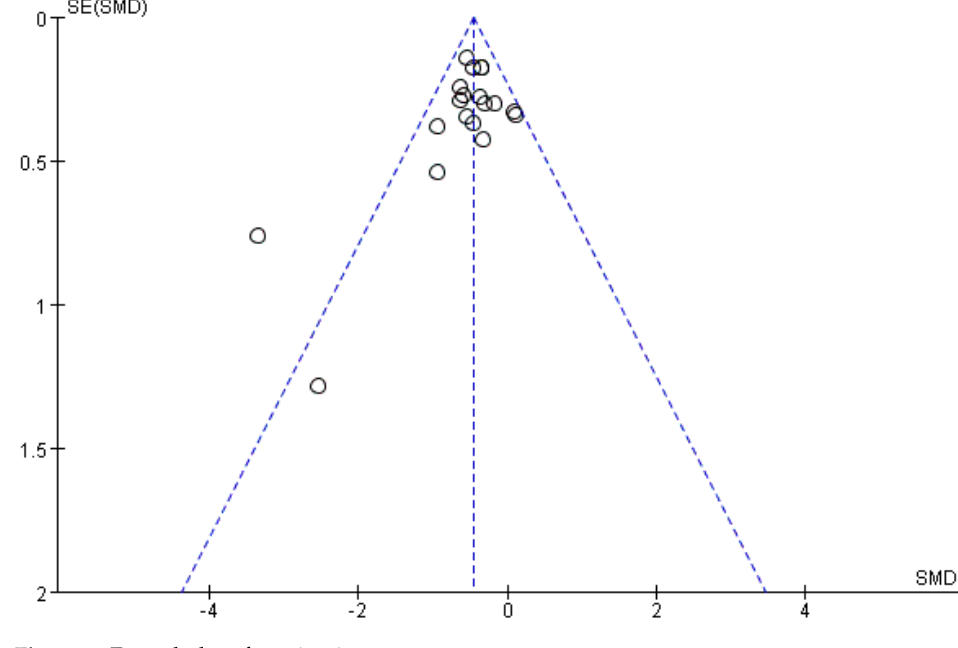
Figure 9. Funnel plot of